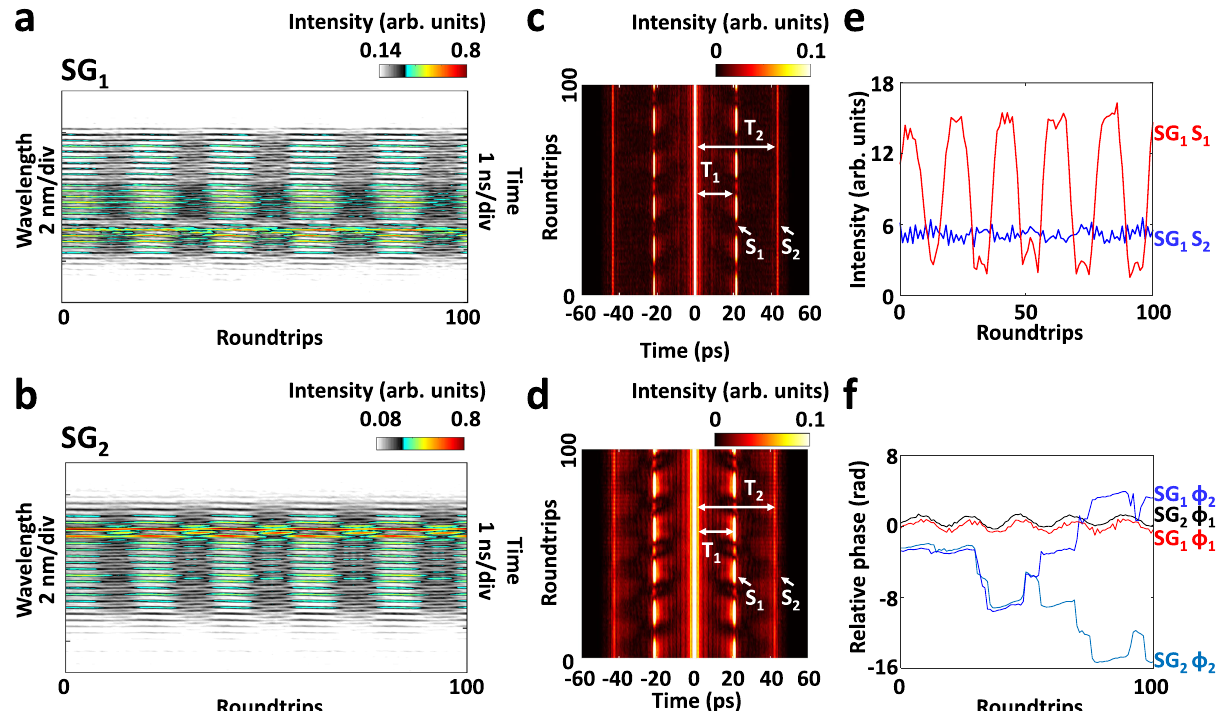
Fig. 5 | Speckle-resolved spectral-temporal dynamics of 3D triple-soliton molecules with equal temporal spacing. a , b Spectral evolutions in SG 1 and SG 2 . c , d Corresponding FAC evolutions of ( a ) and ( b ). Here, T 1 and T 2 denote the temporal delays of the FAC sidelobes (i.e., S 1 and S 2 ). e Intensity variations of the